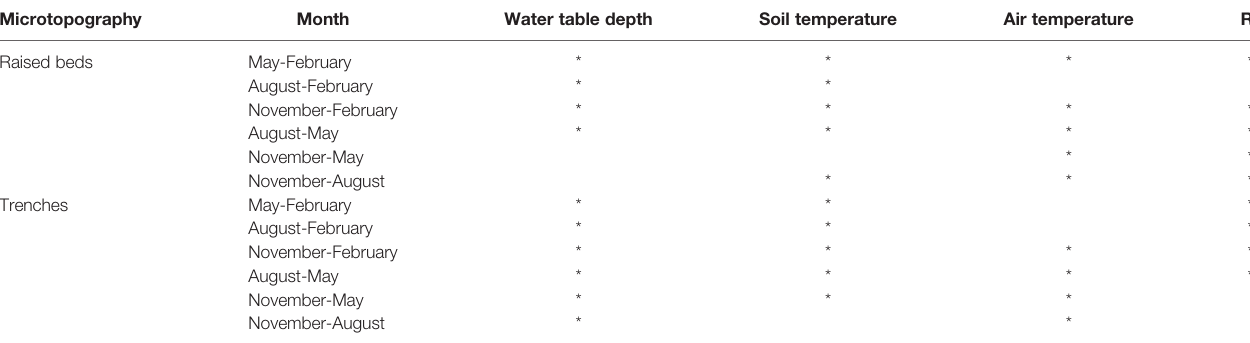
TABLE 4 | Signi fi cant differences (p<0.05) in measurements between months based on Tukeys HSD at 95% con fi dence interval.